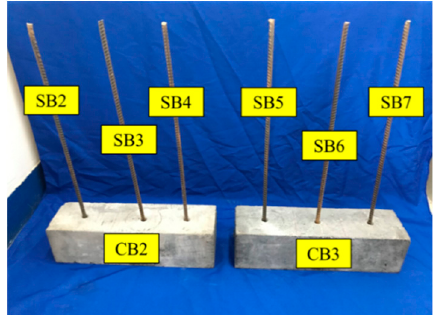
Figure 5. Specimens with anchored steel bars for the pull-out test. Table 1. The material properties of the test specimens